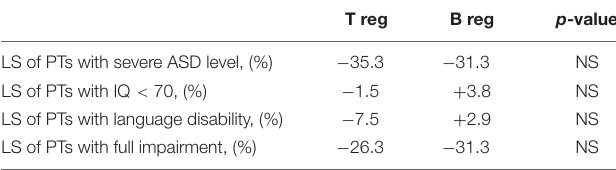
TABLE 4 | Percentage of variation vs. all